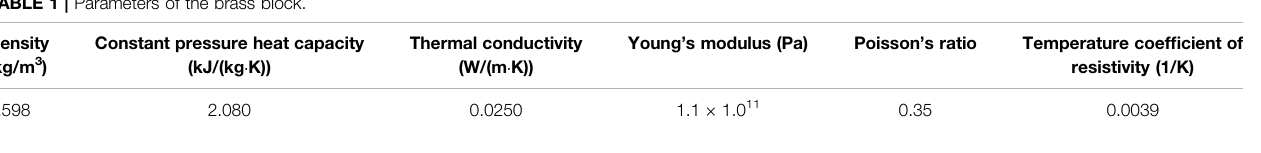
TABLE 1 | Parameters of the brass block. Density (kg/m 3 )